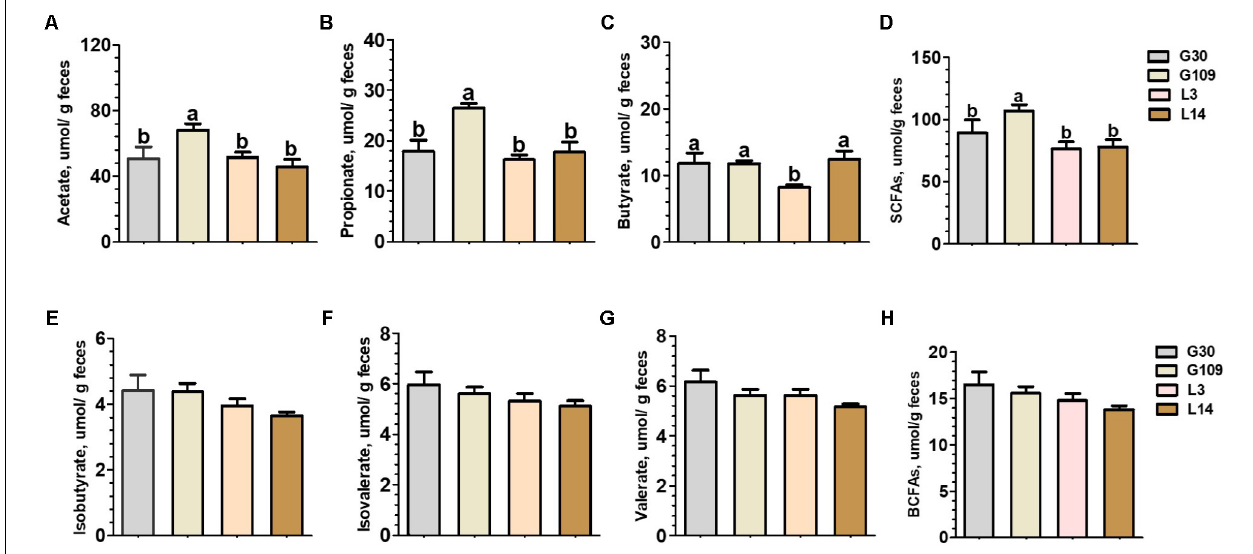
FIGURE 6 | Fecal concentrations of intestinal microbial metabolites in sows during gestation and lactation. (A) acetate, (B) propionate, (C) butyrate, (D) SCFAs, (E) isobutyrate, (F) isovalerate, (G) valerate, and (H) BCFAs. Data are presented as means ± SEM ( n = 12). a,b, significant effect of sampling day (values with different lowercase letters are significantly different). G109, day 109 of gestation; L3, day 3 of lactation. SCFAs, short-chain fatty acid; BCFAs, branch-chain fatty acids. SCFAs is the sum of acetate, propionate, and butyrate; BCFAs is the sum of isobutyrate, isovalerate, and